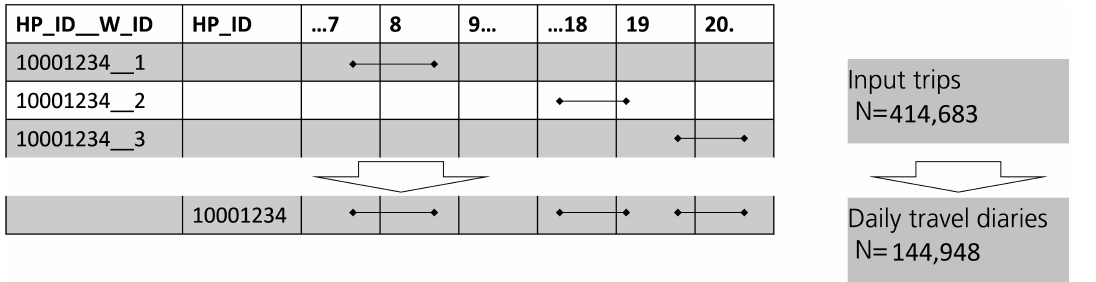
Figure A1. Merging of individual trips to travel